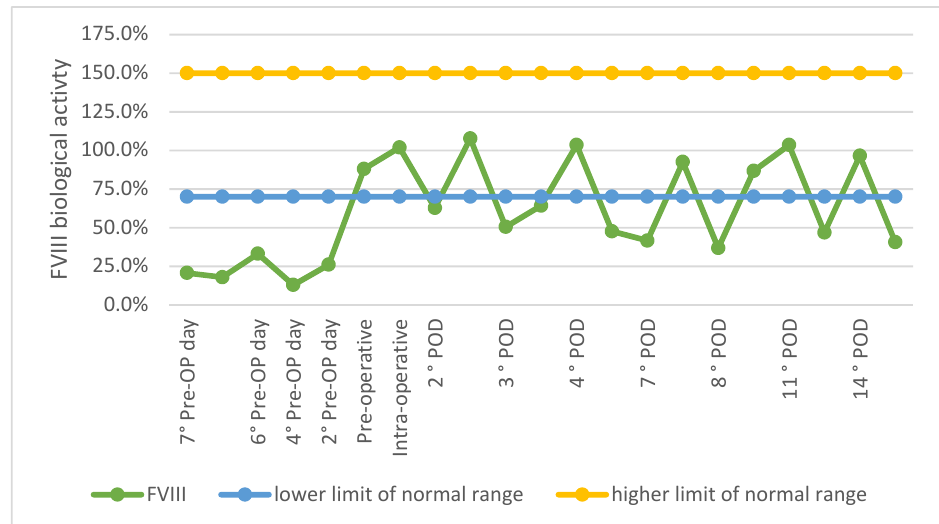
Figure 3 . First hospital stay FVIII biological activity levels preoperatively, intraoperatively and post-operatively. Pre-OP: pre-operative; POD: post-operative day.